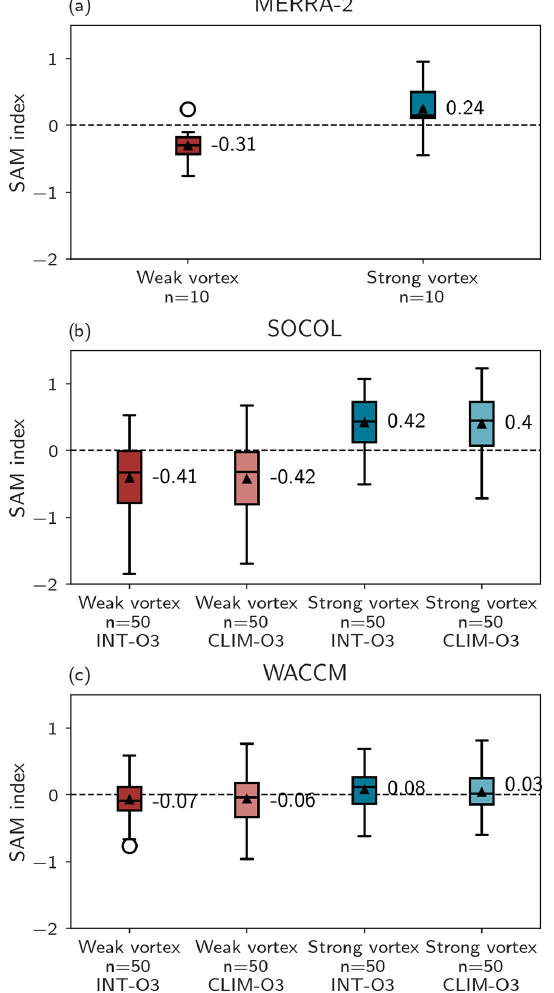
Figure A1. Distribution of the mean 500hPa SAM index averaged over the October–January time period following weak and strong polar vortex anomalies for MERRA-2 (a) , SOCOL INT-O3 and CLIM-O3 (b) , and WACCM INT-O3 and CLIM-O3 (c) . Each box extends from the lower to the upper quartile values of the data, and its whiskers extend from the lower quartile − 1 . 5 IQR to the upper quartile + 1 . 5 IQR. Data points outside the whiskers are shown as circles. The horizontal line marks the median value and the triangle marks the mean of the distribution, which is annotated next to the